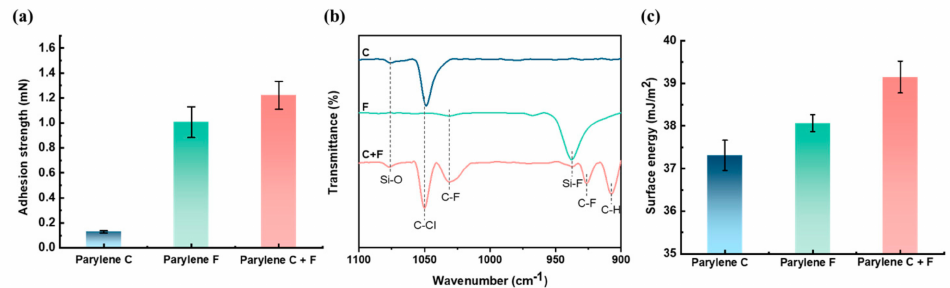
Figure 2. Comparison of the Parylene homopolymer and copolymer films. ( a ) adhesion strength results. ( b ) FTIR results with wavenumber from 1100 to 900 cm − 1 , ( c ) Surface energy results calculated from the contact angles measurements with DI water and Methanol.